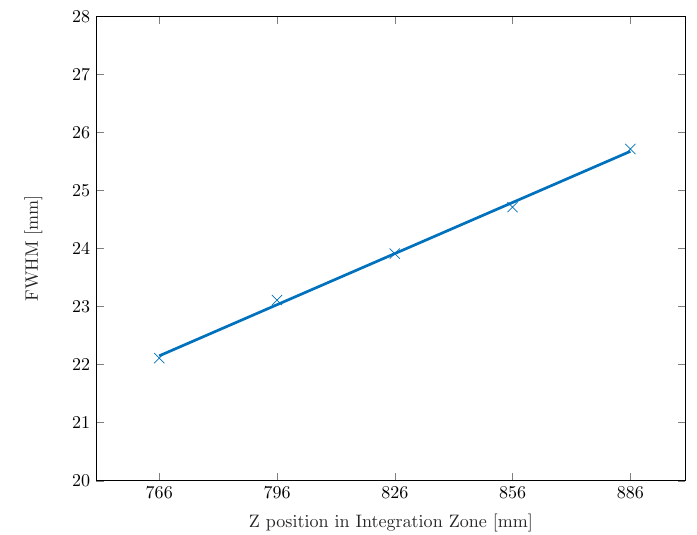
Figure 8. Beam divergence as the FWHM at dedicated VELO modules positions.